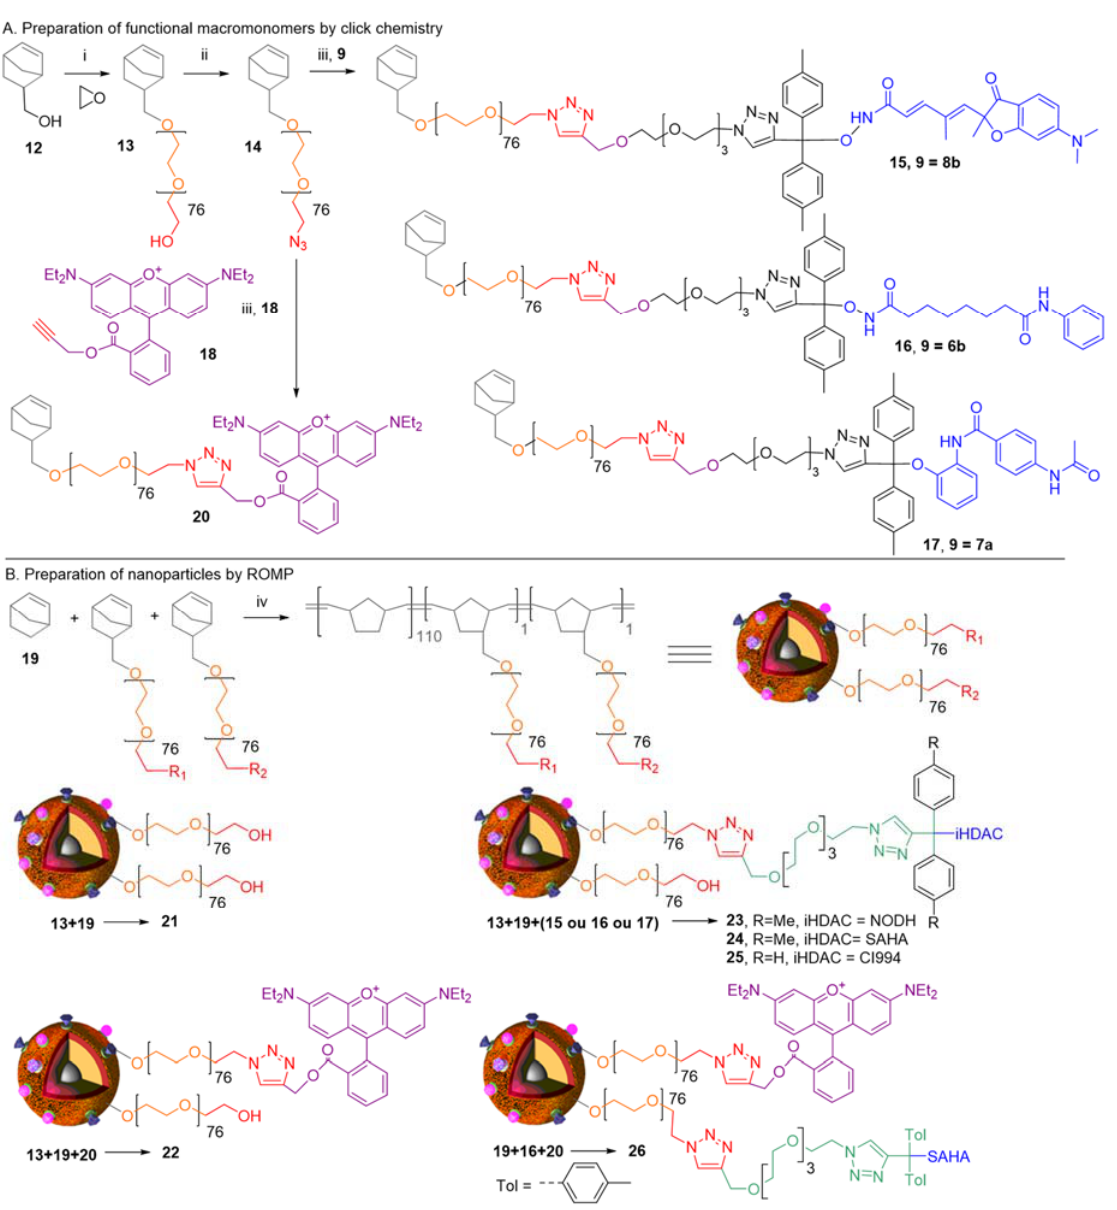
Figure 1. Synthesis of (A) the functional macro ‐ monomers bearing the pH ‐ responsive pro ‐ drugs or a rhodamine fluorescent dye and (B) the functional polymers. A wide range of NPs have been synthesized by ROM co ‐ Polymerization of pro ‐ drug ‐ functionalized macromonomer ( 15, 16, 17 ) with the PEO unfunctionalized macromonomer ( 13 ) in dispersed media. Well ‐ defined spherical NPs from 300 to 380 nm diameter (determined by DLS and TEM) with a hydrophilic PEO shell and a hydrophobic polynorbornene core have been obtained (Figure 1B). The NP composition was determined according to the consumed starting macro ‐ monomers with a reported method detailed in previous research studies [27]. All NPs synthesized exhibited 99% molar of NB 19 and 1% molar of macromonomer carrying drug molecule. The nude NP 21 was prepared from NB 19 and un ‐ functional macromonomer 13 , NP 22 by combination of 19 with 13 and fluorescent macromonomer 20 , whereas NPs 23 , 24, and 25 are synthesized by ROMP of a mixture of NB 19 and un ‐ functional macromonomer 13 with macromonomers 15 , 16, and 17, respectively. Lastly, the ROM co ‐ Polymerization of NB 19 with macromonomers 16 and 20 together afforded NP 26 .